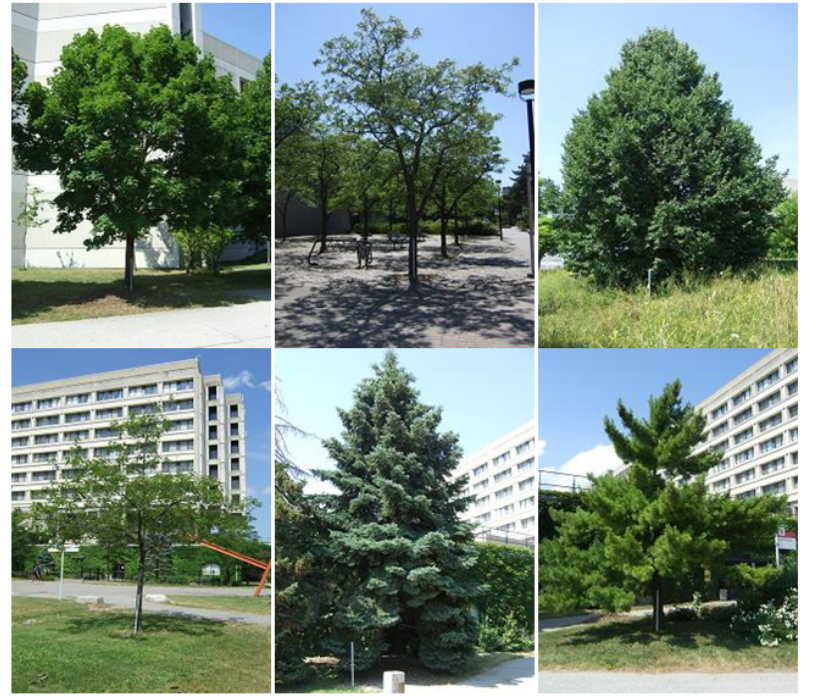
Figure 2. Top left to right: Maple, Ash, and Birch; bottom left to right: Oak, Spruce, and